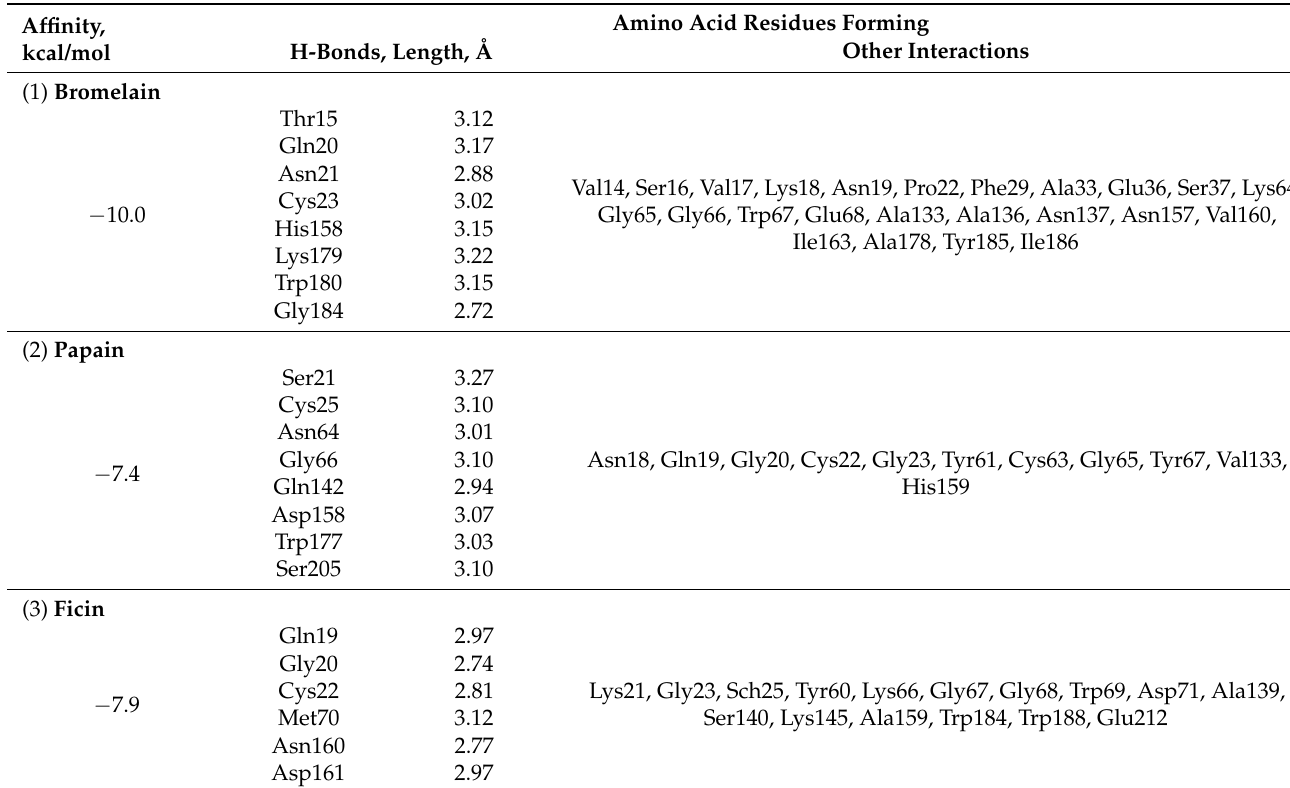
Table 2. The enzyme amino acid residues interacting with 2-(4-acetamido-2-sulfanilamide) chitosan. Amino Acid Residues Forming Affinity, H-Bonds, Length, Å Other kcal/mol